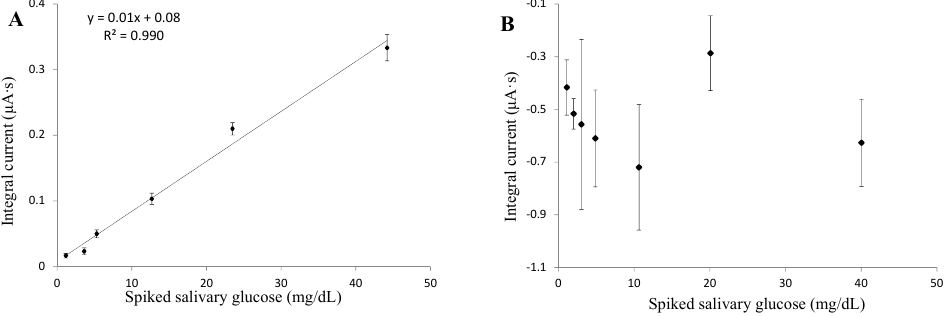
Figure 4. Amperometric tests with effect of different number of (chitosan/gold nanoparticles/glucose oxidase) multi-layer films on electrode ( A ) three multi-layer films; ( B ) six multi-layer films. Error bars = ±standard deviation and n = 3.